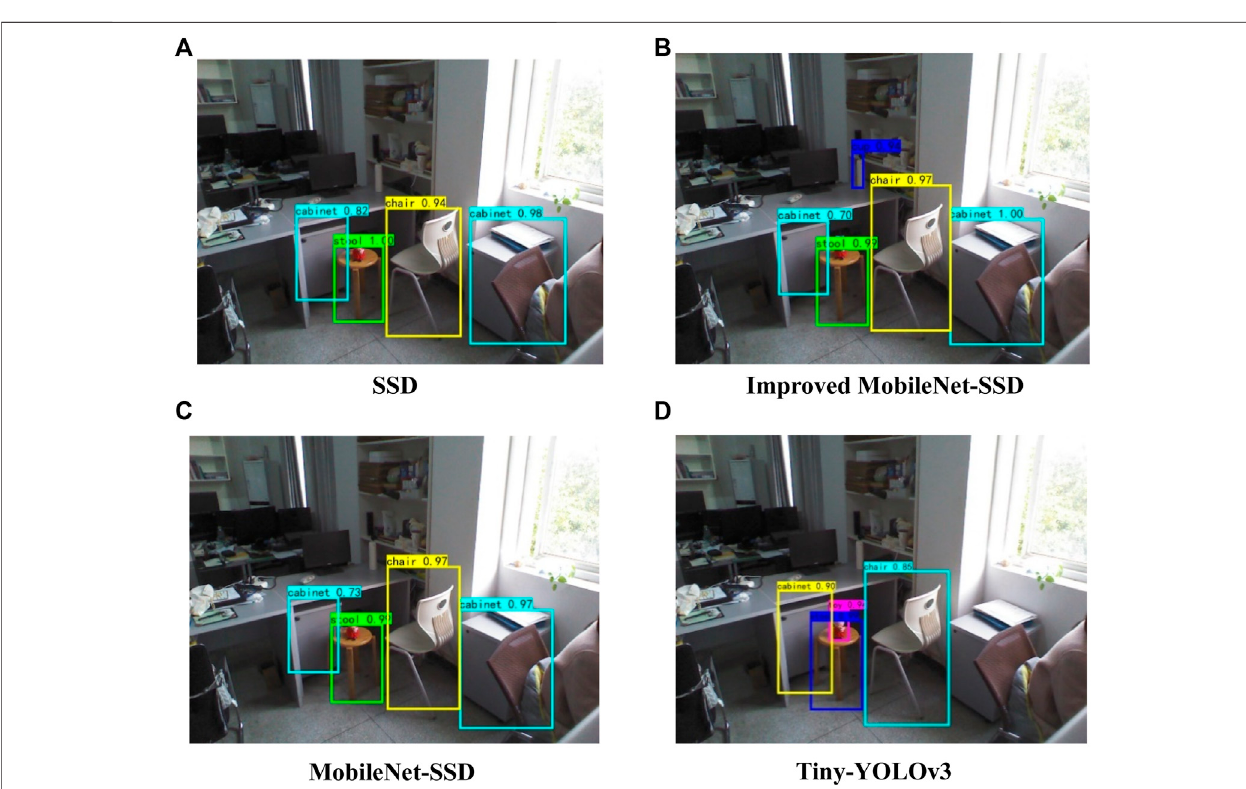
FIGURE 10 | Comparison of detection effects between SSD and the lightweight target detection model. (A) SSD. (B) Improved MobileNet-SSD. (C) MobileNet- SSD. (D) Tiny-YOLOv3.